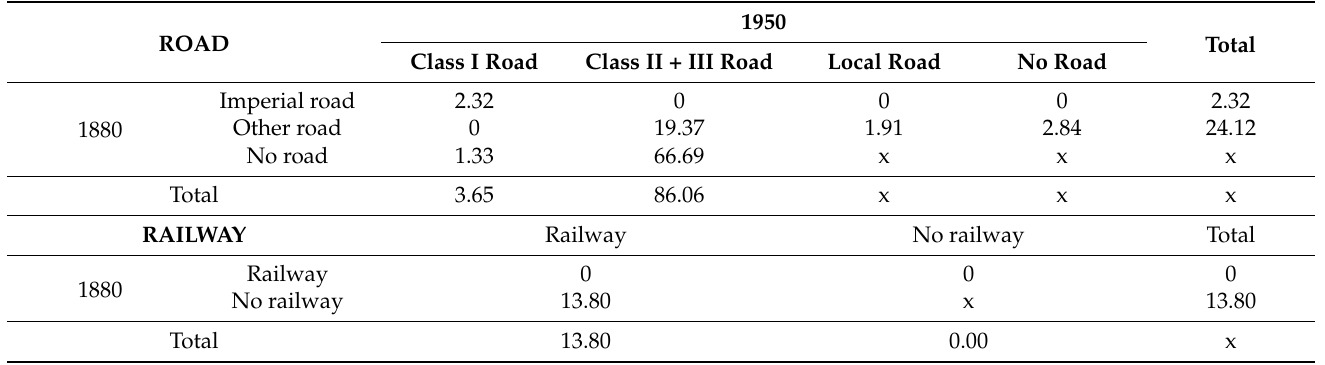
Table 6. The transport network changes: the lakes ( n = 4) constructed in 1880/1950 [km].